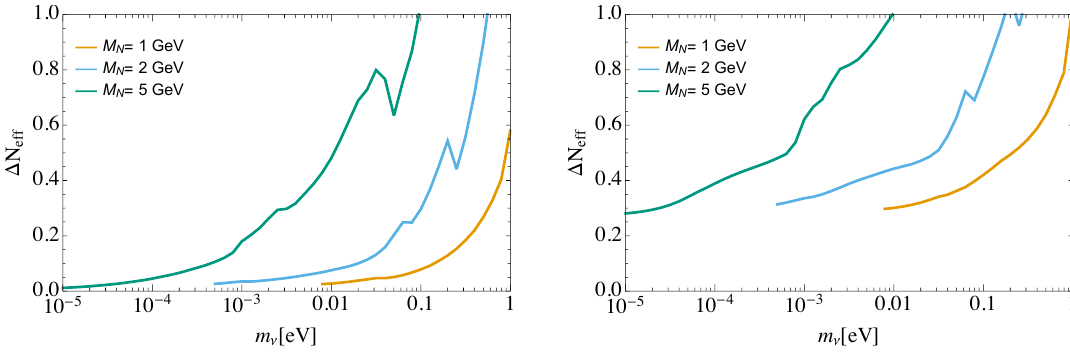
Figure 3 . (cid:1) N e(cid:11) as a function of the mass of the lightest left handed SM neutrino in the universal right handed neutrino limit. Curves are shown for right handed neutrinos at 1, 2, and 5 GeV. Left plot is for (cid:15) = 0 while the right plot is for (cid:15) = 0 : 05. family result of section 4.1 and (cid:12)gure 2. However, even in this case it is possible for all right handed neutrinos to contribute to the temperature di(cid:11)erence between the A and the B sectors. In (cid:12)gure 3 we show the contribution to (cid:1) N from twin states as a function of the e(cid:11) lightest SM neutrino mass. In the (cid:12)gure (cid:1) N was estimated numerically, going e(cid:11)